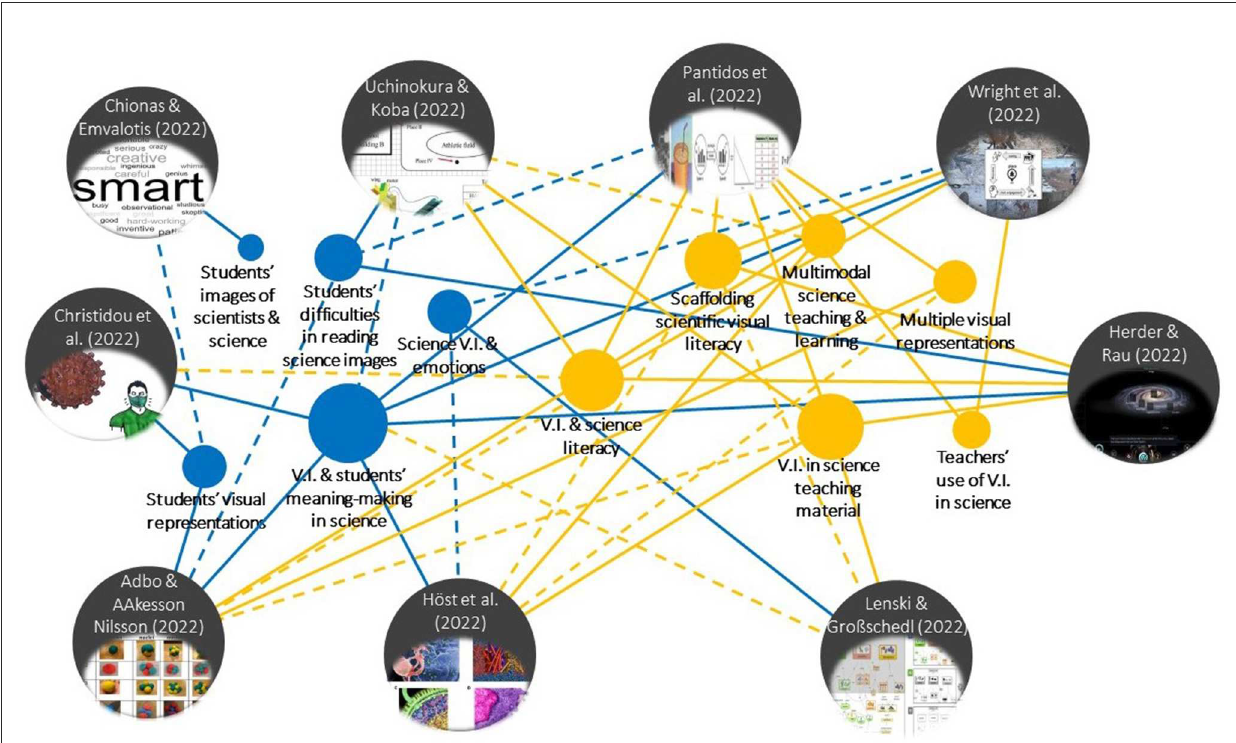
FIGURE1 Themes covered by the articles in the “Visual images in science education” Research